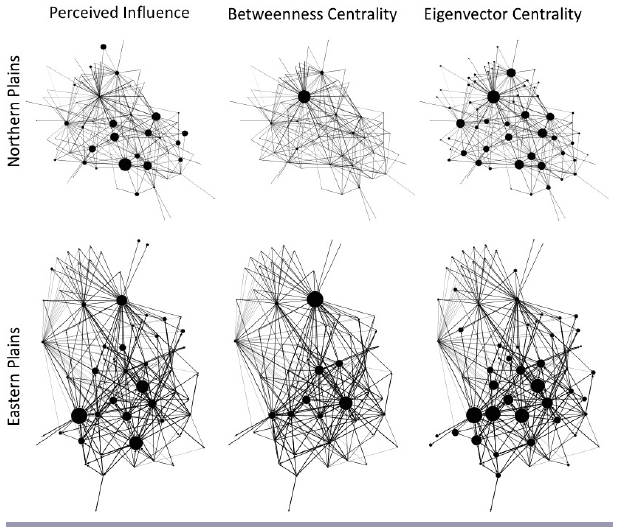
Fig. 3. Information networks for the Northern Plains and Eastern Plains. Nodes are sized by (1) perceived influence (2) betweenness centrality and (3) eigenvector centrality. In the Northern Plains, actors perceived to have high influence do not align with actors with high betweenness centrality. Influential actors are spread throughout the network. In the Eastern Plains, actors with high perceived influence align with actors with high eigenvector centrality, indicating an integrated and influential cluster of actors in the